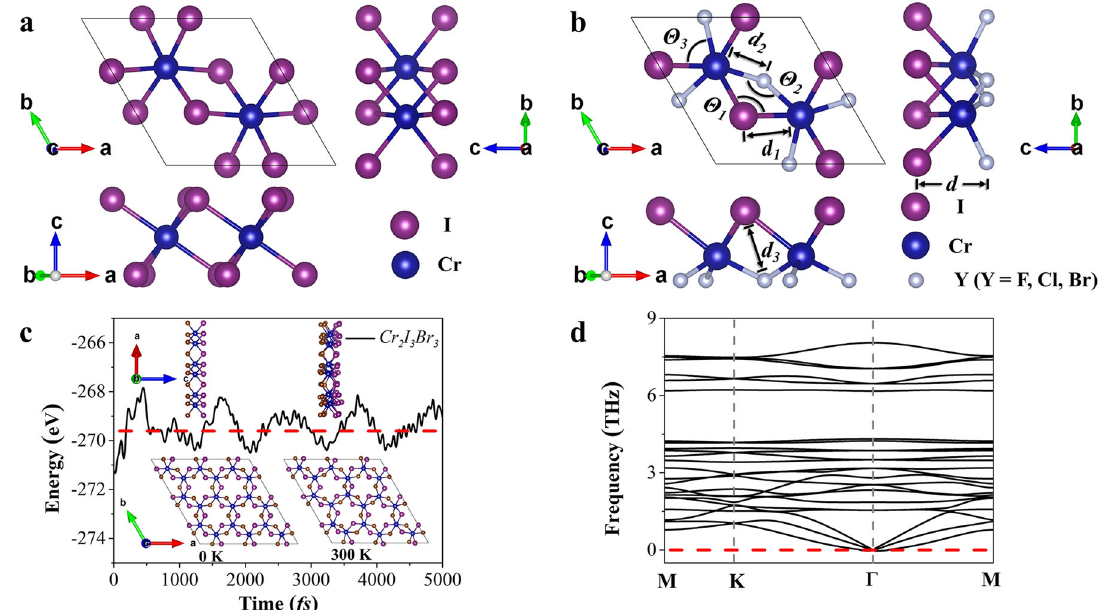
Fig. 1 Structural con fi gurations and stability. a , b Top and side views of 2D structure isolated Cr 2 I 6 monolayer and Janus Cr 2 I 3 Y 3 (Y = F, Cl, or Br) monolayer. The solid lines indicate the primitive cells. The amethyst, blue, and grey spheres represent the Iodine, Chromium, and Y (Florine, Chlorine, or Bromine) atoms, respectively. c Change of free energies over time in AIMD simulations at 300 K and the snapshots at 0 K and 300 K after a 5000 f s simulation for the Janus Cr 2 I 3 Br 3 monolayer. d Phonon spectra of the Janus Cr 2 I 3 Br 3 monolayer.